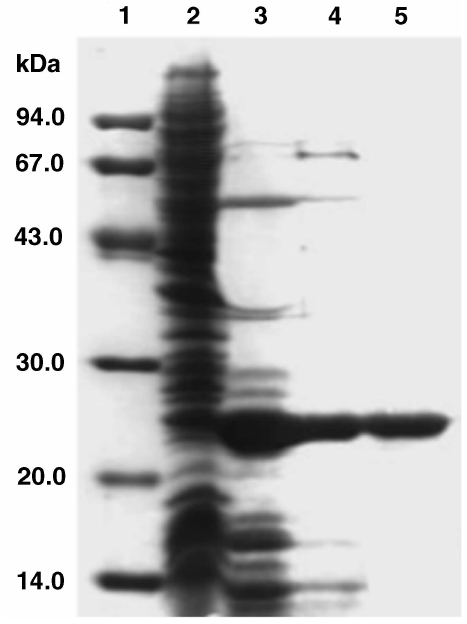
Figure 1. Purification of recombinant Pyrococcus horikoshii pyro- phosphatase ( Ph PPase). Lane 1, molecular mass markers; Lane 2, crude extract of induced cells; Lane 3, supernatant of crude extract af- ter heat treatment at 85 °C for 30 min; Lane 4, HiTrap Q column peak fractions; and Lane 5, Sephacryl S-200 HR 26/60 column peak frac- tions. The gel was stained with Coomassie brilliant blue.